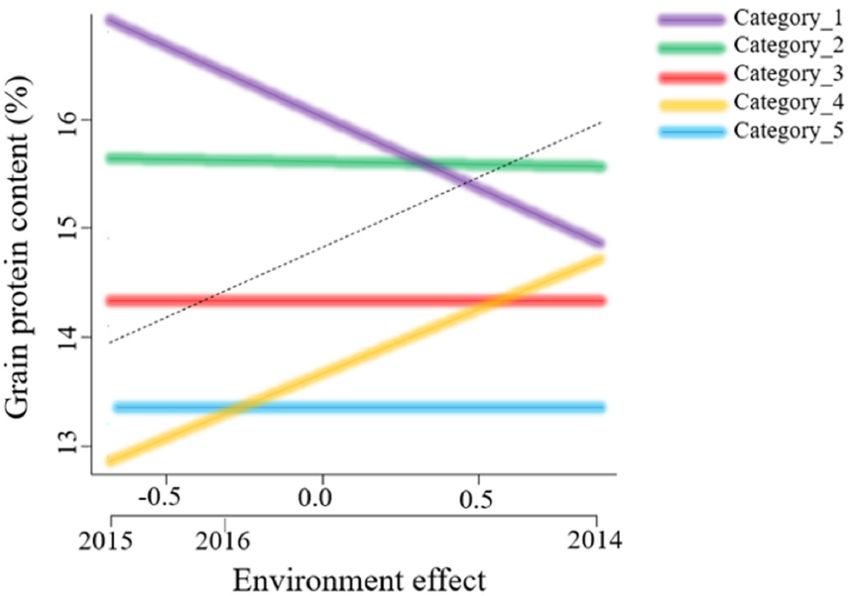
Figure 2. Trends for the stability index and GPC observed in the NAM 175 population. The slopes of the lines represent the stability index, the X-axis depicts the environmental effect, and the Y-axis shows the grain protein content.